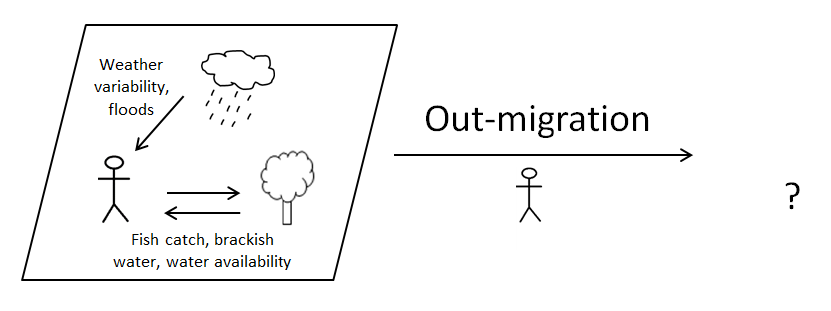
Fig. A1.12 Diagram drafted for the ABM described by Smajgl et al. (2013; 2015a; 2015b)